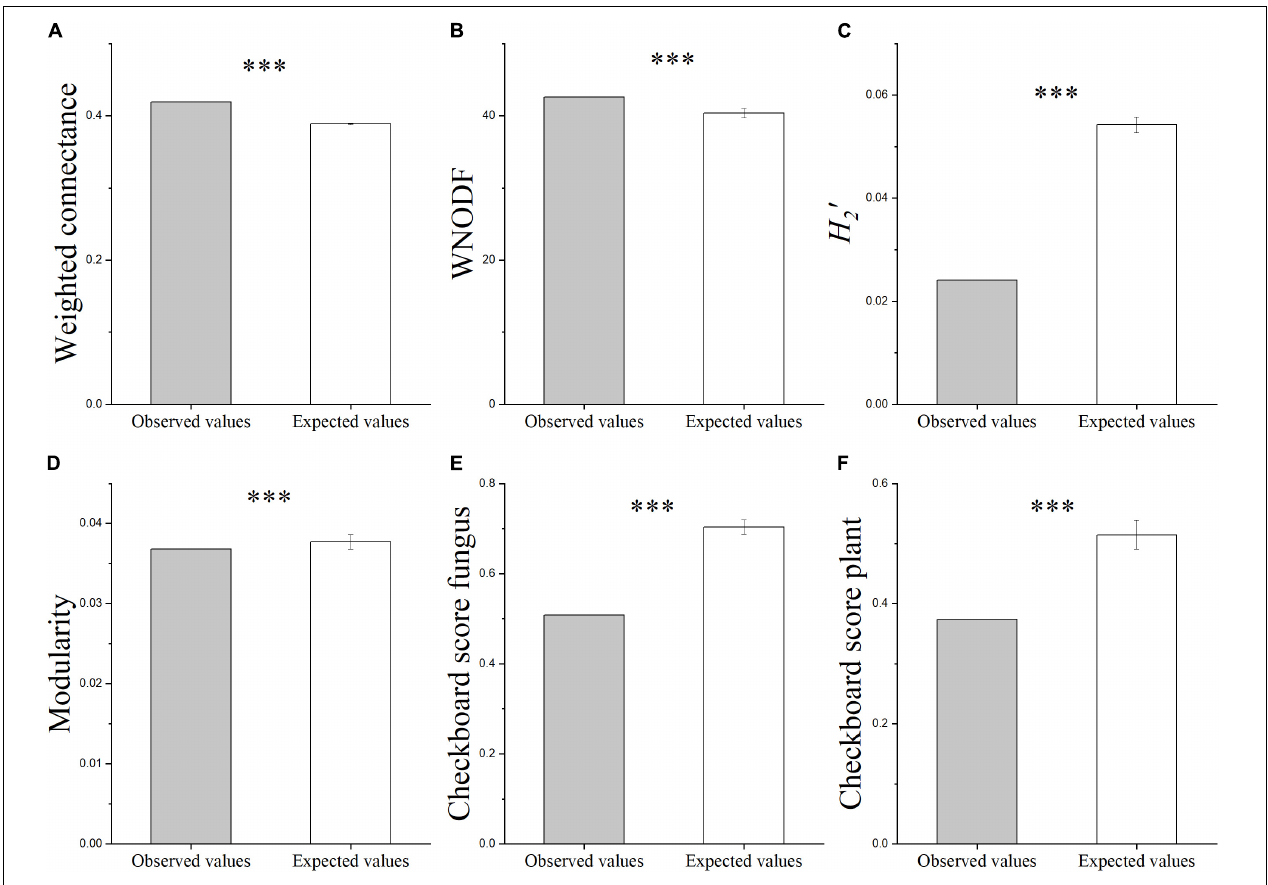
FIGURE 7 | The characteristics of different plant-AMF networks. Weight connectance (A) , WNODF (B) , H 2 (cid:48) (C) , modularity (D) , checkerboard score fungus [ (E) , degree of avoiding overlapping of plants in the fungal community], and checkerboard score plant [ (F) , degree of avoiding overlapping of fungi in the plant community]. Asterisks indicate significant differences between the observed and expected values according to the t -test ( ∗∗∗ P < 0.001; bars indicate SE).